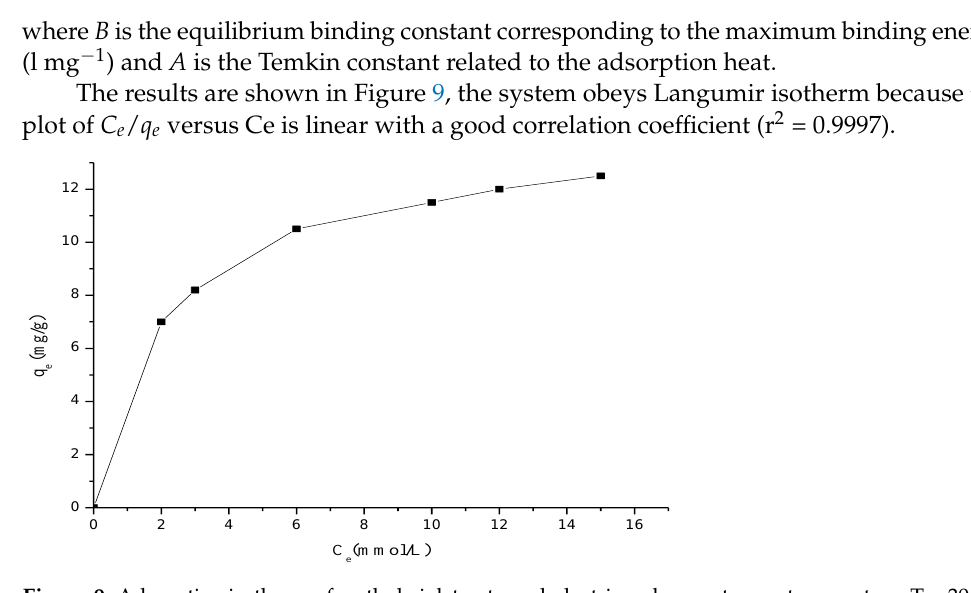
Figure 9. Adsorption isotherm of methyl violet onto cyclodextrin polymer at room temperature, T = 30 °C.